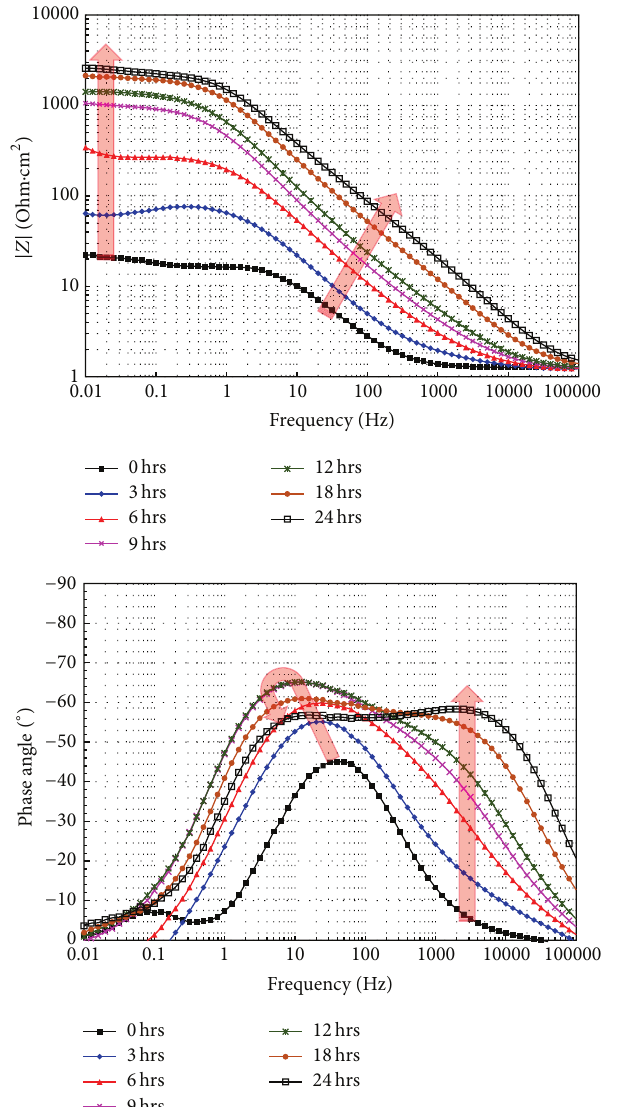
Figure 9: Nyquist and Bode plots for 1018 carbon steel in CO 2 - saturated (3% NaCl + 10% diesel) emulsion with 25 ppm of linoleic amide at 50 ∘